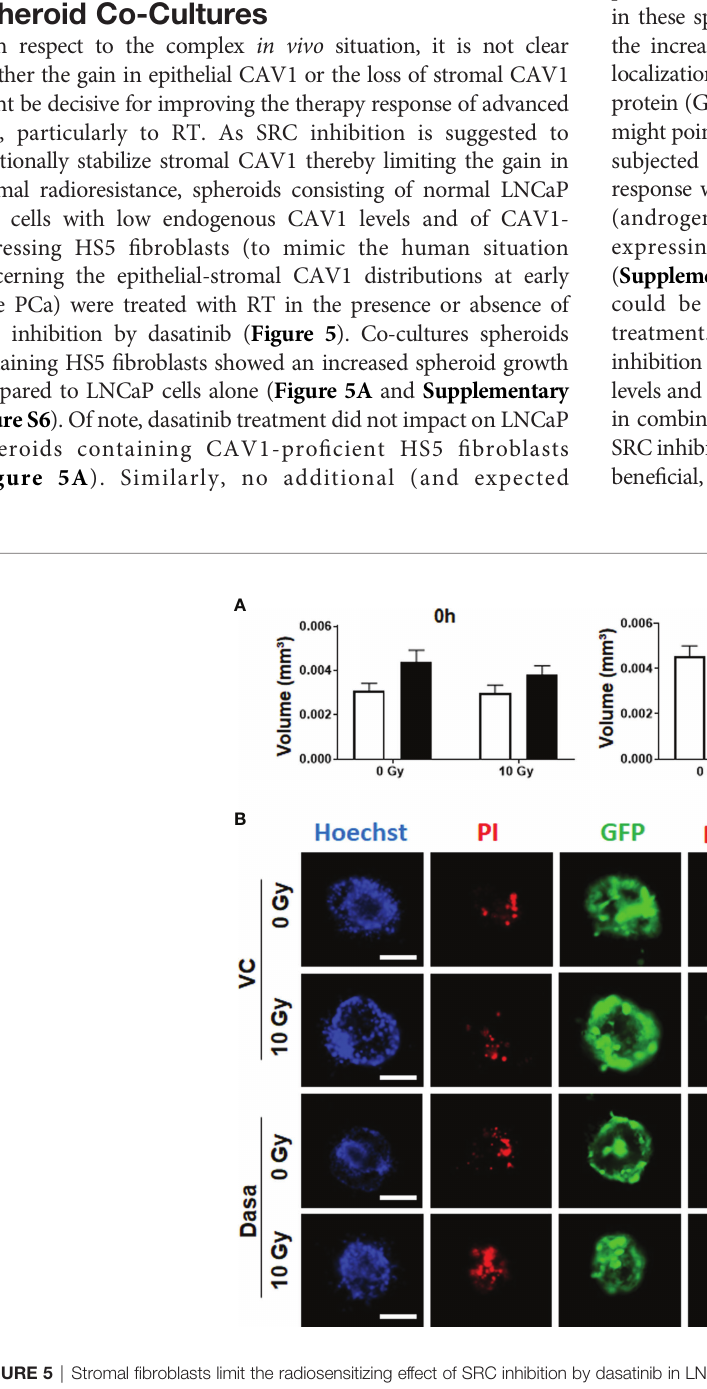
FIGURE 5 | Stromal fi broblasts limit the radiosensitizing effect of SRC inhibition by dasatinib in LNCaP spheroid co-cultures. CAV1 expressing stromal fi broblasts (HS5) were co-cultured with LNCaP control (Ctrl) cells expressing low endogenous CAV1 levels and the reporter green fl uorescent protein (GFP) in hanging drops for 24 h. After formation of spheroids, cells were plated in growth factor-reduced Matrigel mixed with normal growth medium (1/2, v/v) supplemented with dasatinib or vehicle control (VC) and irradiated with 0 Gy or 10 Gy. Pictures were taken at the time of irradiation (0 h) and 48 h later. (A) Spheroid growth was measured and the respective volumes were calculated for 0 and 48 h after irradiation. Data were derived from 3 to 5 individual experiments, where at least 10 spheroids per condition and per experiment each were measured. (B) Cell death was analyzed afterwards by fl uorescence microscopy using propidium iodide. Hoechst 33342 was used for nuclei staining. Representative fl uorescent images from the individual experiments are shown (48 h time point). Scale bars represent 100